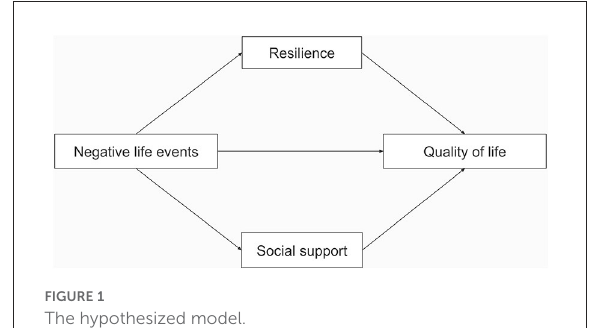
FIGURE1 The hypothesized